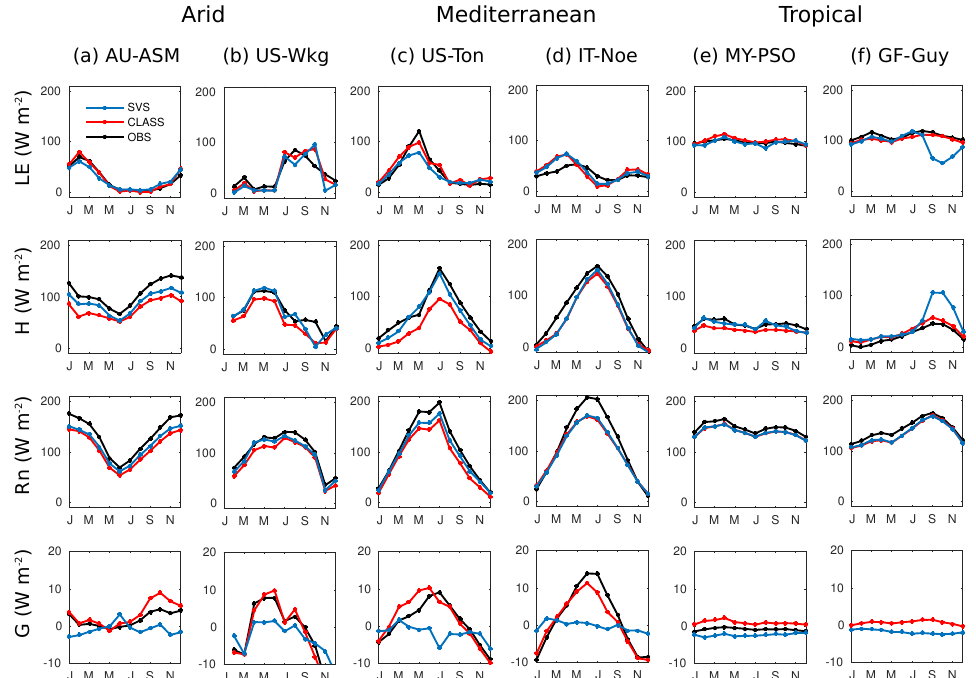
Figure 3. Mean annual cycles of latent heat flux ( LE ), sensible heat flux ( H ), net radiation ( R n ) and soil heat flux (G) at arid sites (( a ) AU-ASM, ( b ) US-Wkg), mediterranean sites (( c ) US-Ton, ( d ) IT-Noe) and tropical sites (( e ) MY-PSO, ( f ) GF-Guy). Black lines correspond to observations, blue and red lines correspond to SVS and CLASS simulations, respectively. Filtered 30-min data for observations and simulations were used to compute the mean annual cycles. Note that the y-axis for G differs from the rest of the